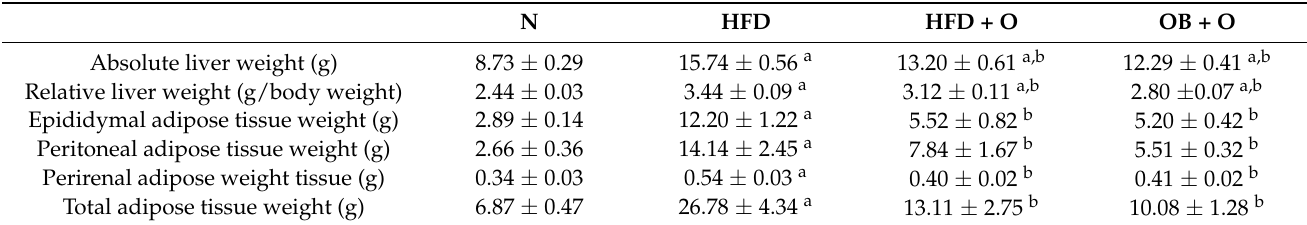
Table 3. Weights of liver and adipose tissues of rats in the experimental groups.